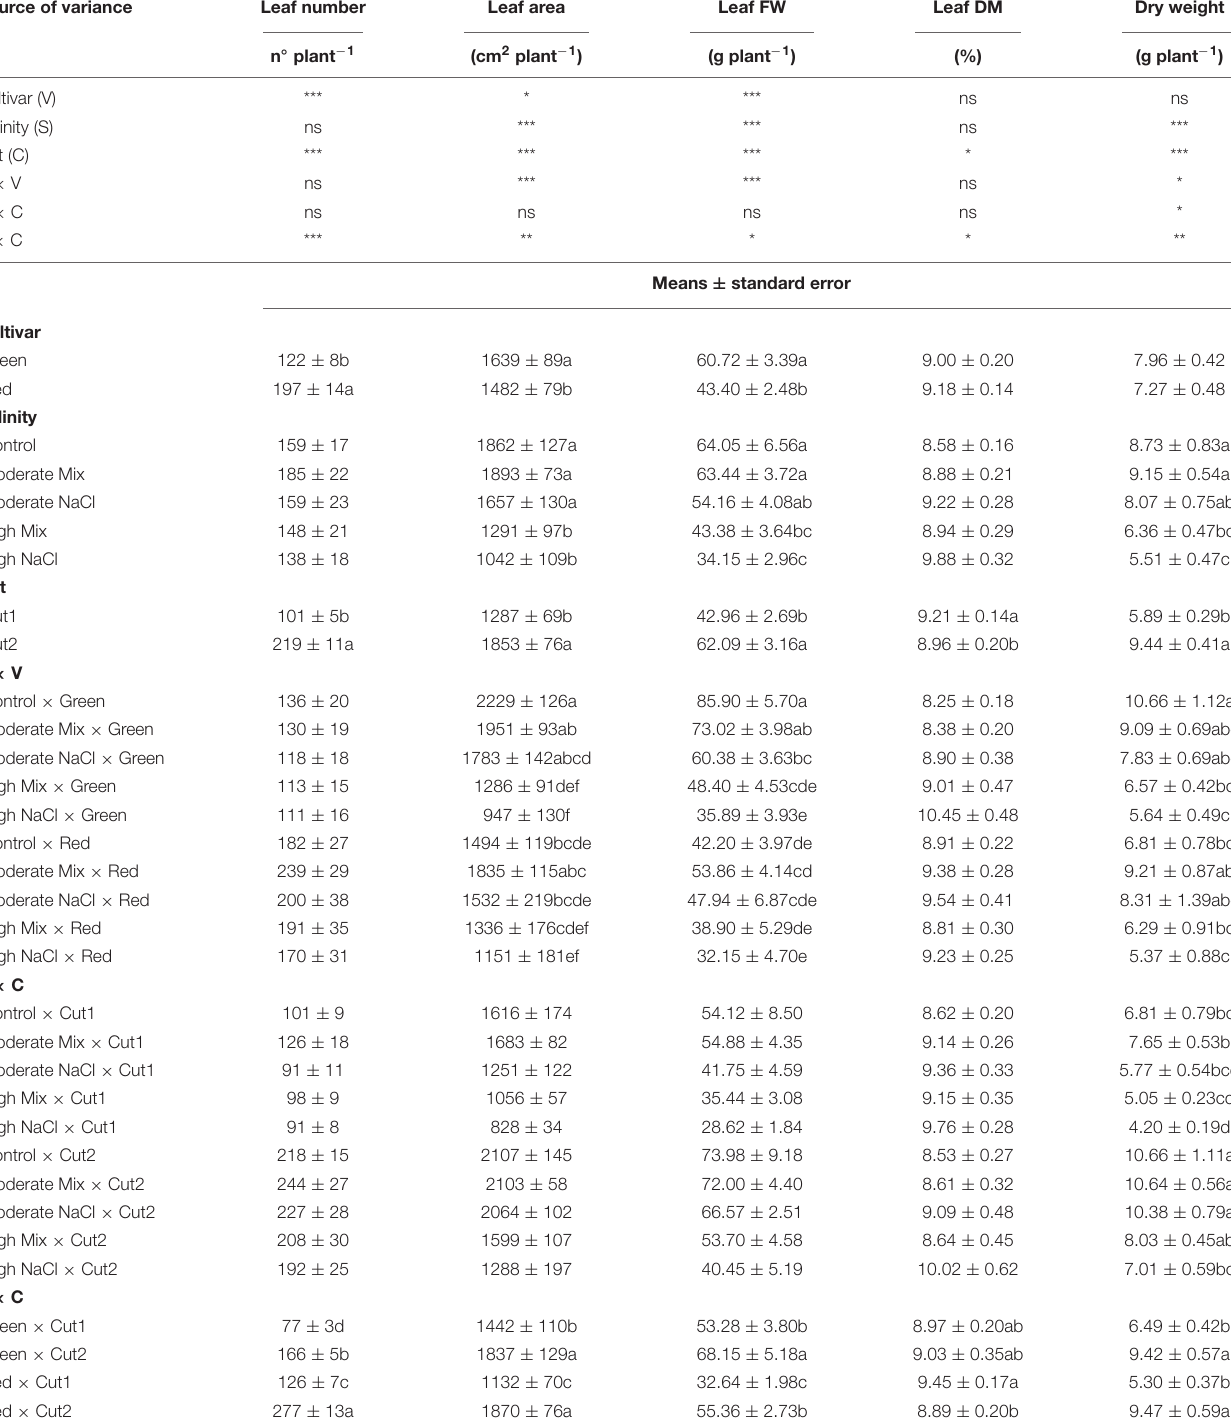
TABLE 2 | Analysis of variance (ANOVA) and mean comparisons for leaf number, leaf area, leaf fresh weight, leaf dry matter percentage, and dry weight of the Green and Red cultivars grown hydroponically under iso-osmotic salinity treatments and harvested in two sequential cuts. Source of